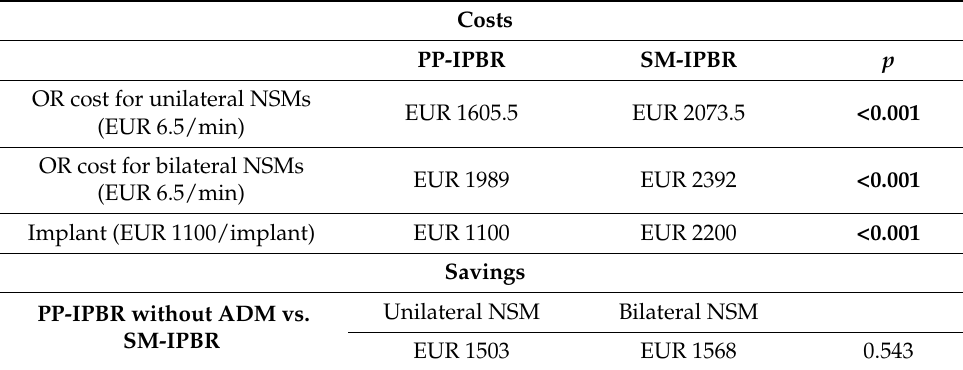
Table 6. Economic